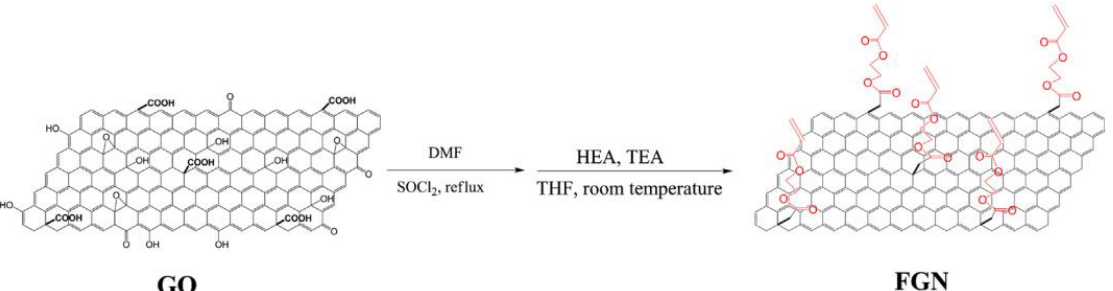
Figure 3. Schematic illustration for the preparation of functionalized graphene oxide (FGO) [71]. (Reproduced from [71] with permission; Copyright 2013